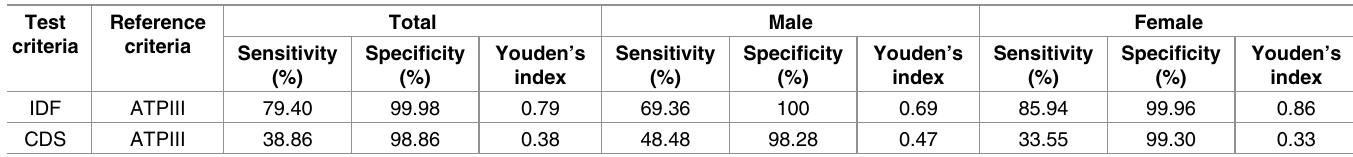
Table 4. Analysis on validity of different criteria for MS.